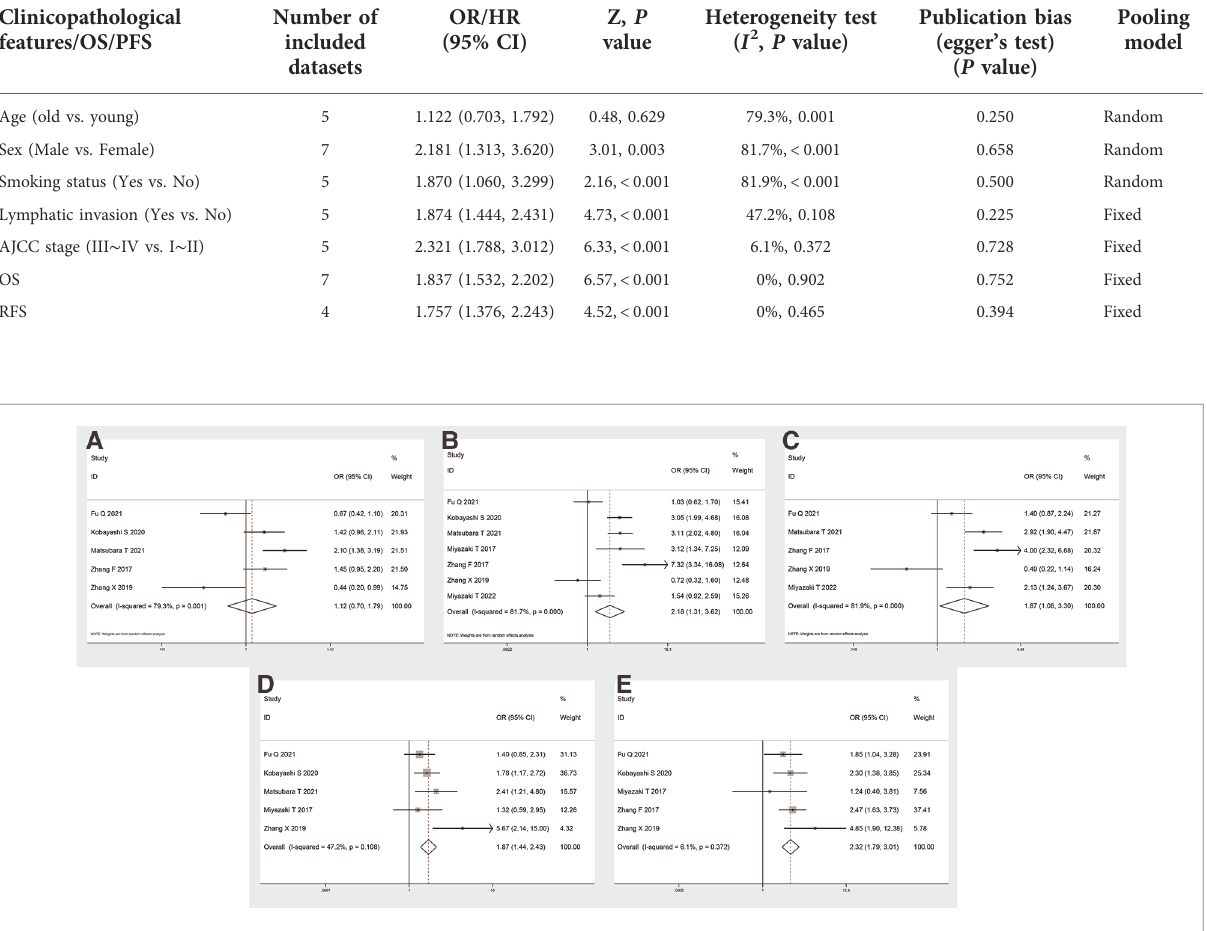
FIGURE 2 Forest plot of the CAR and clinicopathological characteristics. Forest plot evaluating the ORs of the correlation between CAR and ( A ) age, ( B ) sex, ( C ) smoking status, ( D ) lymph node metastasis, and ( E ) AJCC stage. OR, odds ratio; CAR, C-reactive protein to albumin ratio; AJCC, American Association of